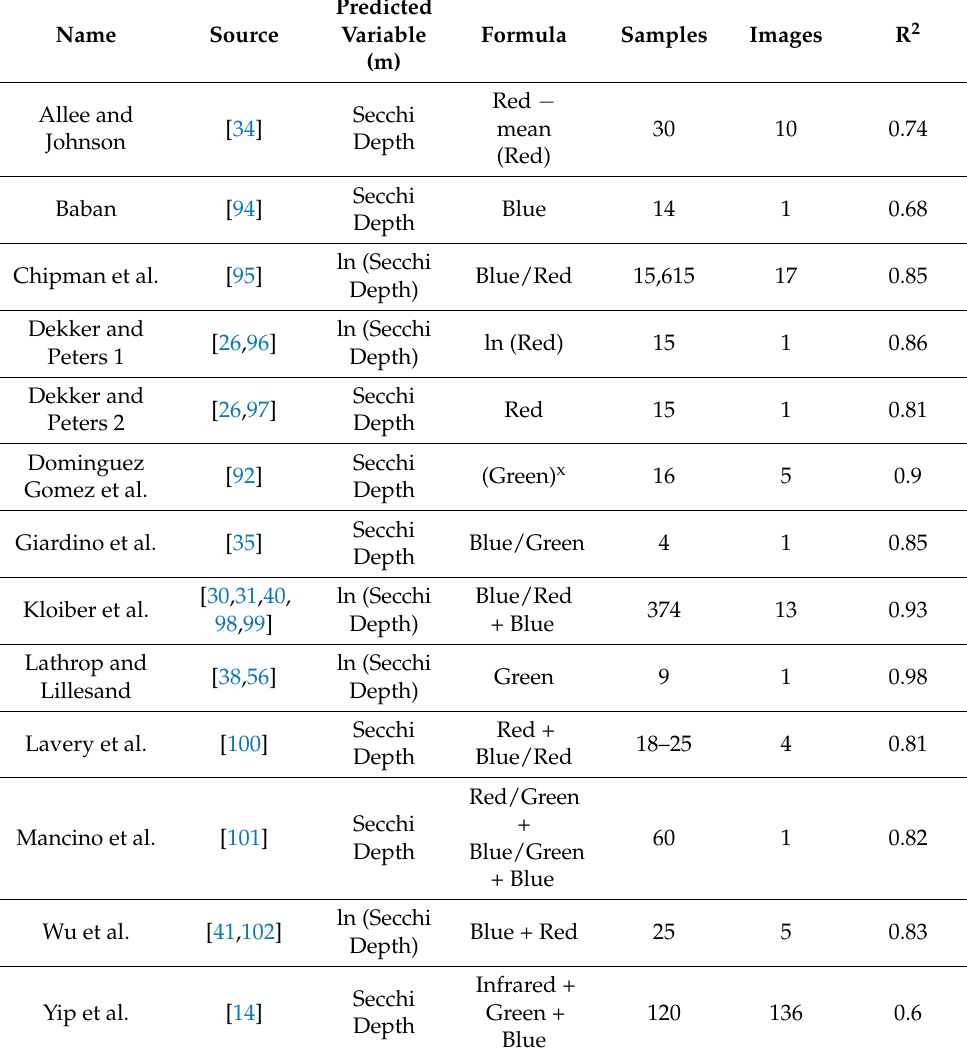
Table 1. Description of published algorithms for predicting water clarity, as reported by original sources. Ln indicates natural logarithm. R 2 is reported by the original authors on their predicted variable, including any transformations. Any operation (e.g., ln (Red)) is applied to the pixels in the buffer zone surrounding each sampling